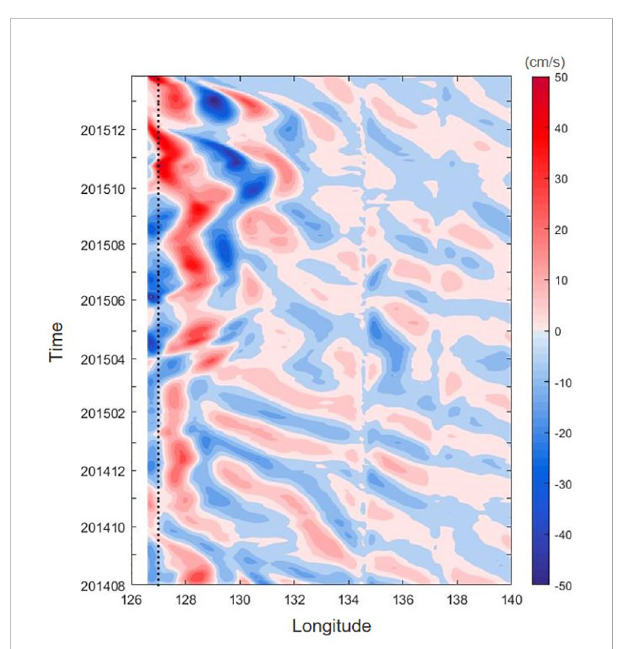
FIGURE 11 The meridional velocity anomaly at 605 m along 8°N from September 2014 to February 2016 derived from the OFES outputs. Black dotted-line indicates the mooring